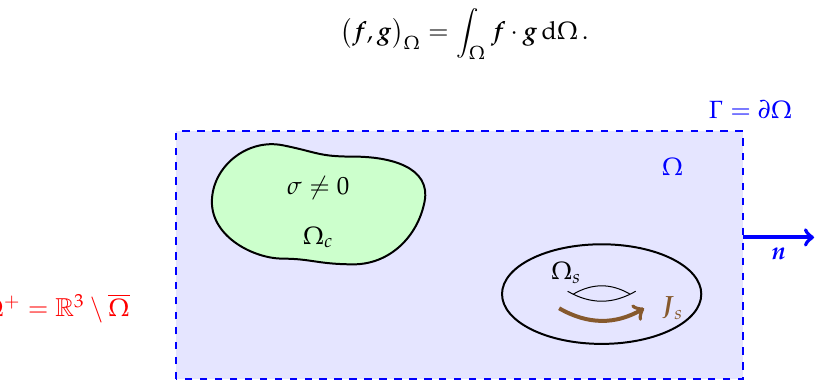
Figure 1. Embedding domain Ω with conducting part Ω c and source current region Ω s